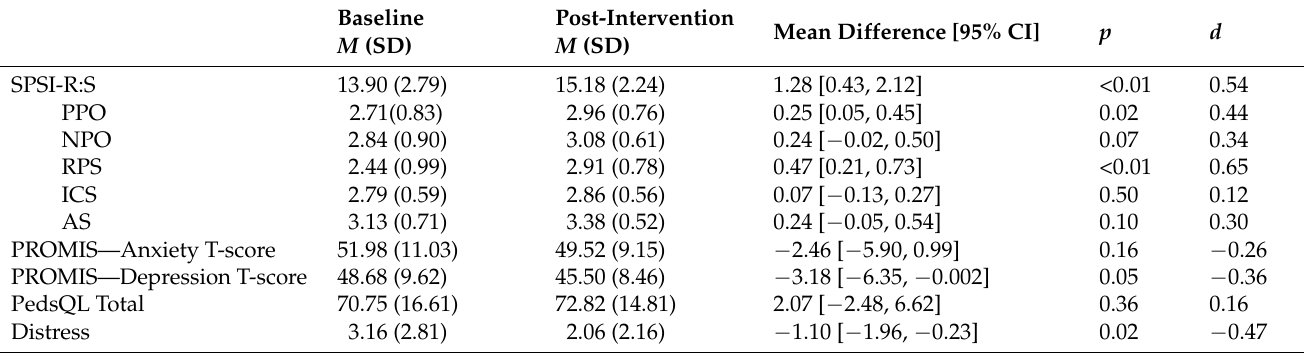
Table 4. Changes in Secondary Psychosocial Outcomes from Baseline to Post-Intervention ( n =